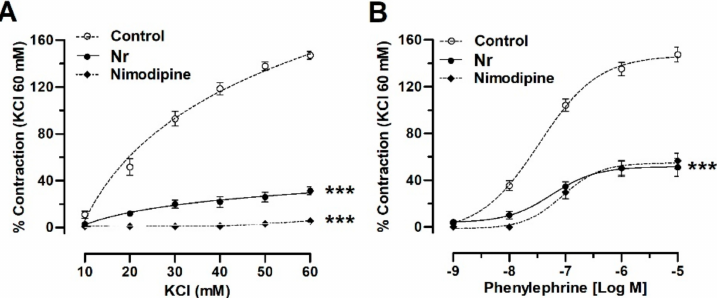
Figure 8. N. ramosissima decreases the vascular contractile response to KCl and PE. The vascular tissue was pre-incubated in absence (control) or presence of 100 µ g / mL of extract or nimodipine (10 -6 M) for 20 min before adding KCl (10–60 mM) ( A ) or PE (10 − 9 − 10 − 5 M) ( B ). Data are the average ± SEM of 5 independent experiments. Statistically significant di ff erences: *** p < 0.001 vs